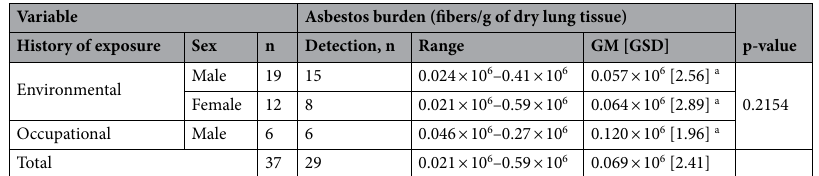
Table 3. ANOVA results of asbestos burden in lung tissues by TEM examination. GM geometric mean concentrations; GSD geometric standard deviation.